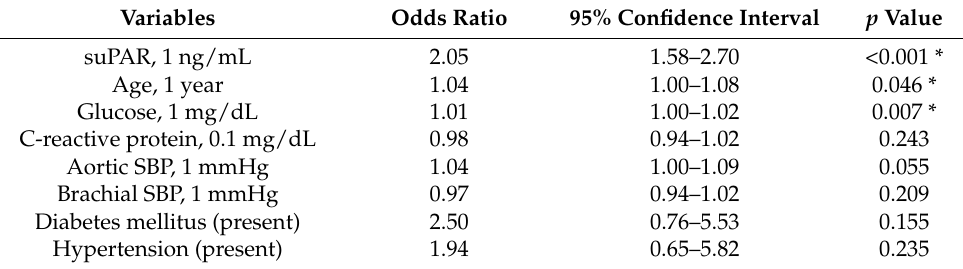
Table 2. Factors correlated to arterial stiffness, determined by multivariable logistic regression analysis.